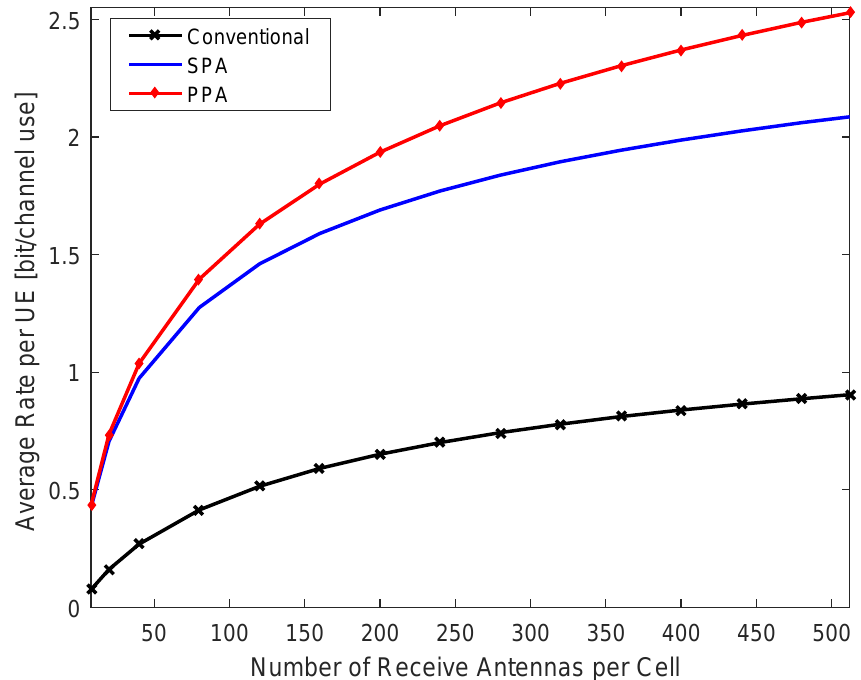
Figure 8. Average uplink rate per user for various numbers of antenna elements using a maximum ratio combining (MRC)